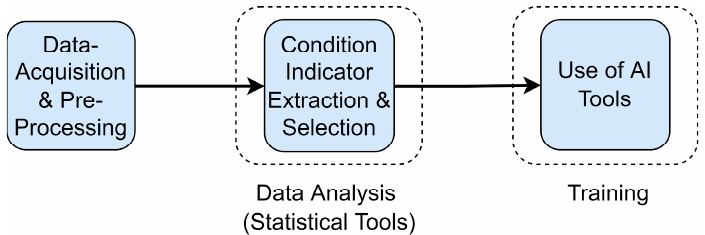
Figure 13. A summary of how AI is used for fault classi fi cation. Adapted from [63].